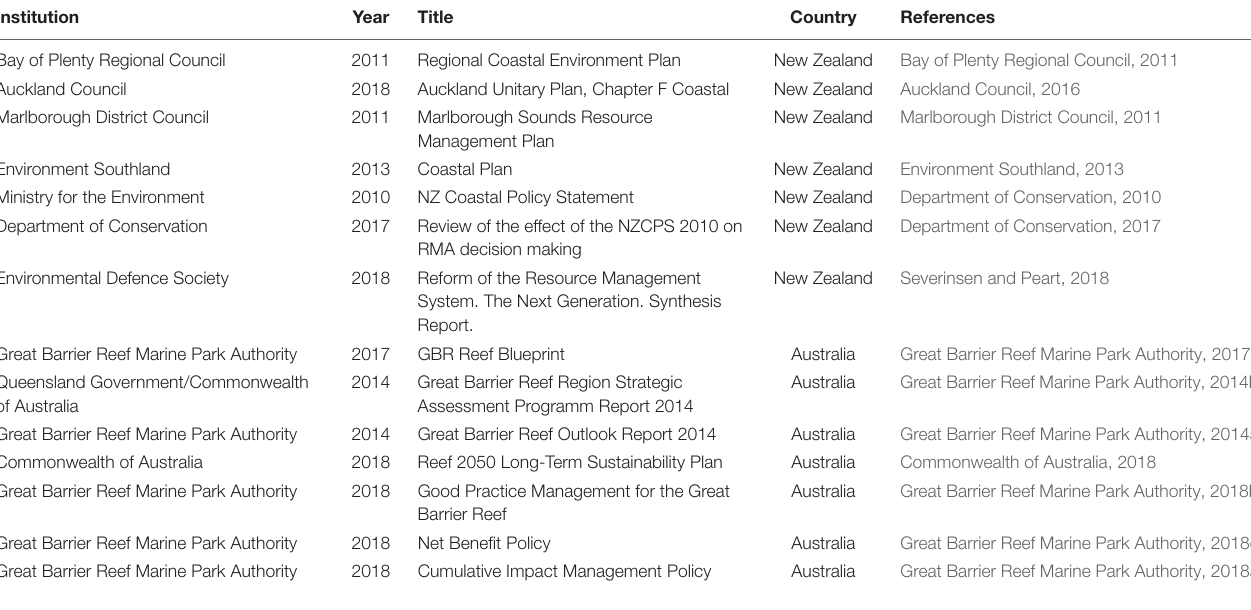
TABLE 1 | Policy documents analysed to understand the governance and legislative arrangements regulating activities and the management of cumulative effects in Aotearoa NZ and the GBRMP.